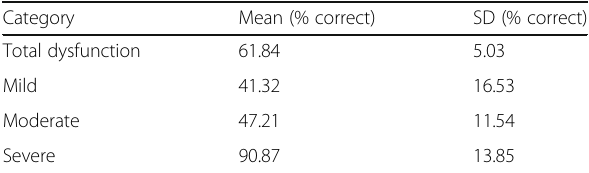
Table 2 Experiment 1: Mean percentage accuracy for the ventricular function categorization task when detection